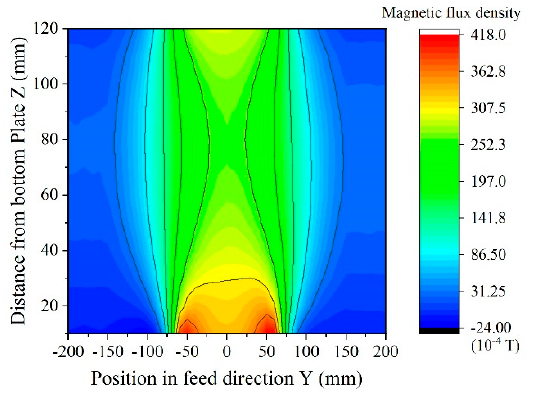
Figure 11. Side view of magnetic field distribution (from [12]).